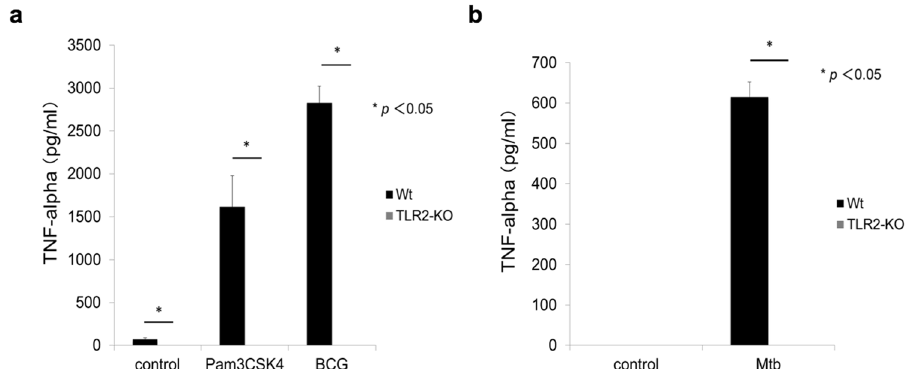
Figure 5. TLR2 is critical for TNF- α production from THP1 macrophages upon mycobacterial infection. ( a ) THP1 macrophages and its TLR2-KO cells were stimulated with the TLR2 ligand, Pam3CSK4 (50 ng/ ml) or infected with BCG (multiplicity of infection = 10) for 24 hours, and the amount of TNF- α in the cell culture supernatant (n = 3) was measured by ELISA. ( b ) THP1 macrophages and TLR2-KO cells were infected M . tuberculosis (multiplicity of infection = 10) for 24 hours, and the amount of TNF- α in the cell culture supernatant (n = 3) was measured by ELISA. ANOVA was used to test for the differences of in